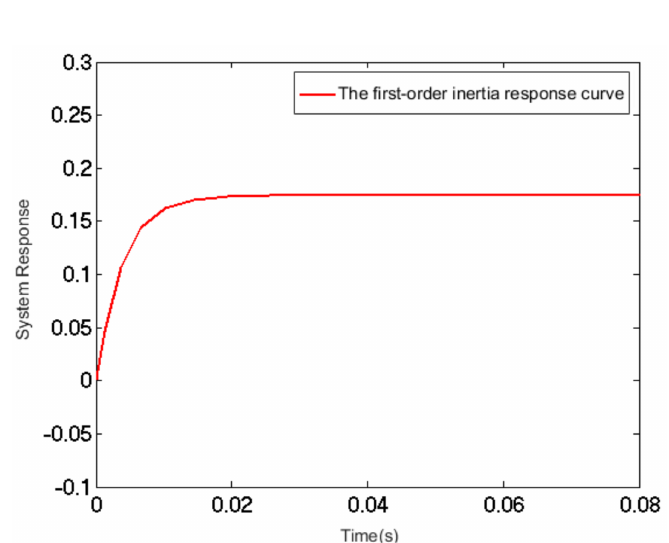
Figure 5. The first-order inertia response curve of PZT mathematical